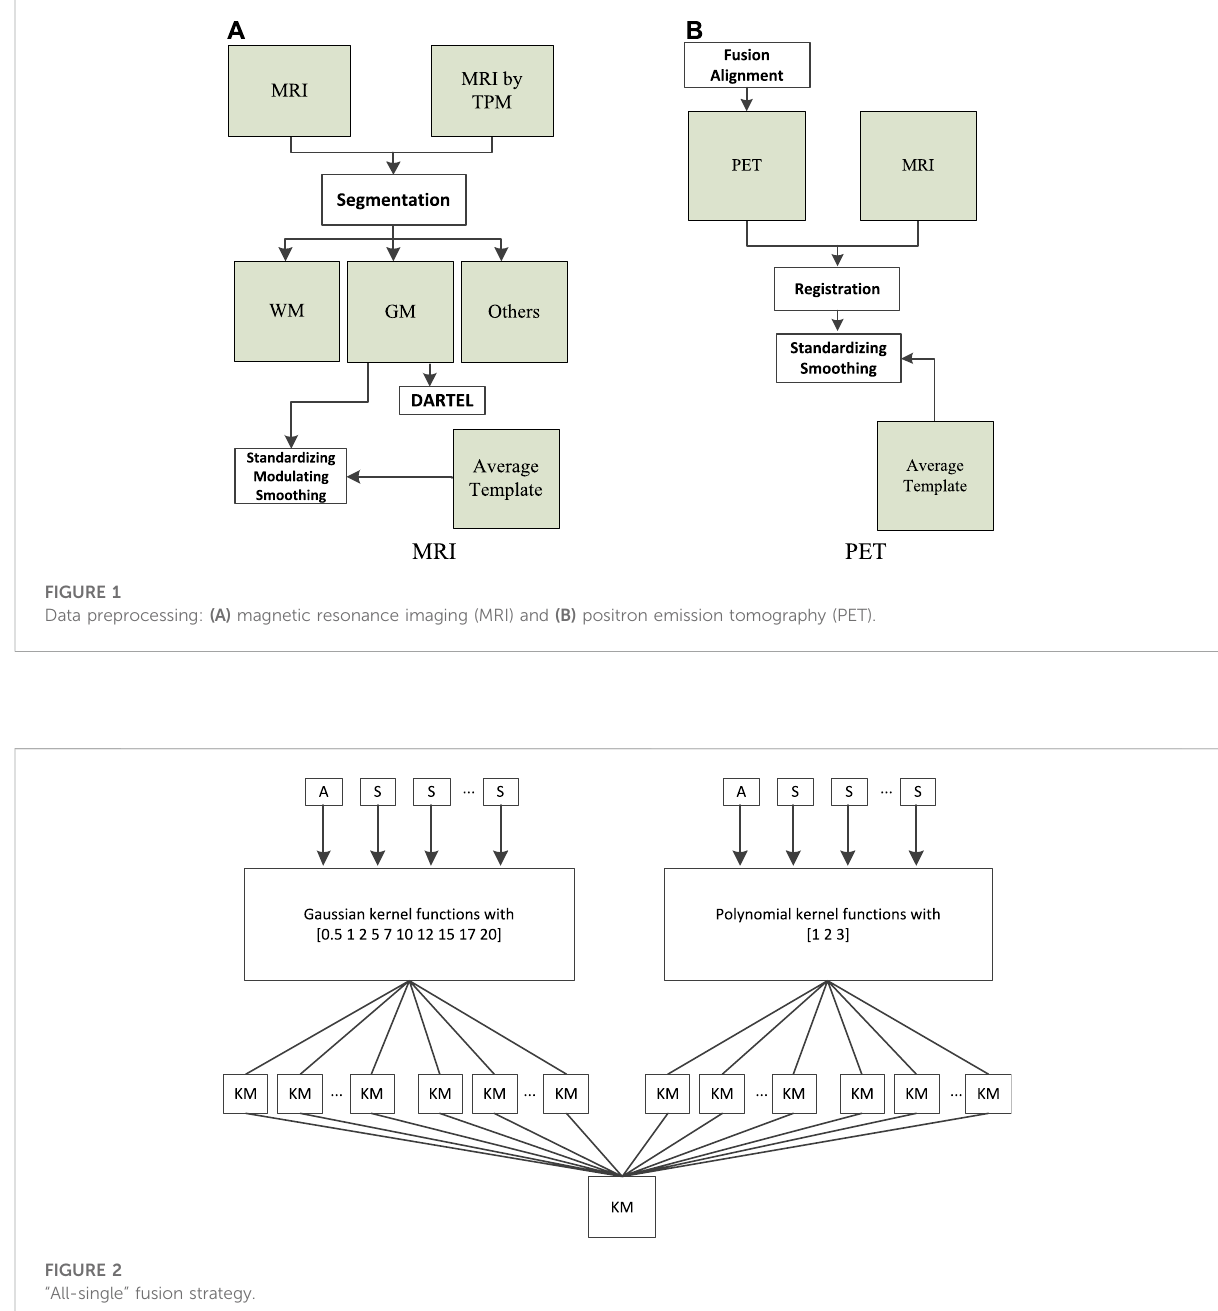
FIGURE 2 “ All-single ” fusion